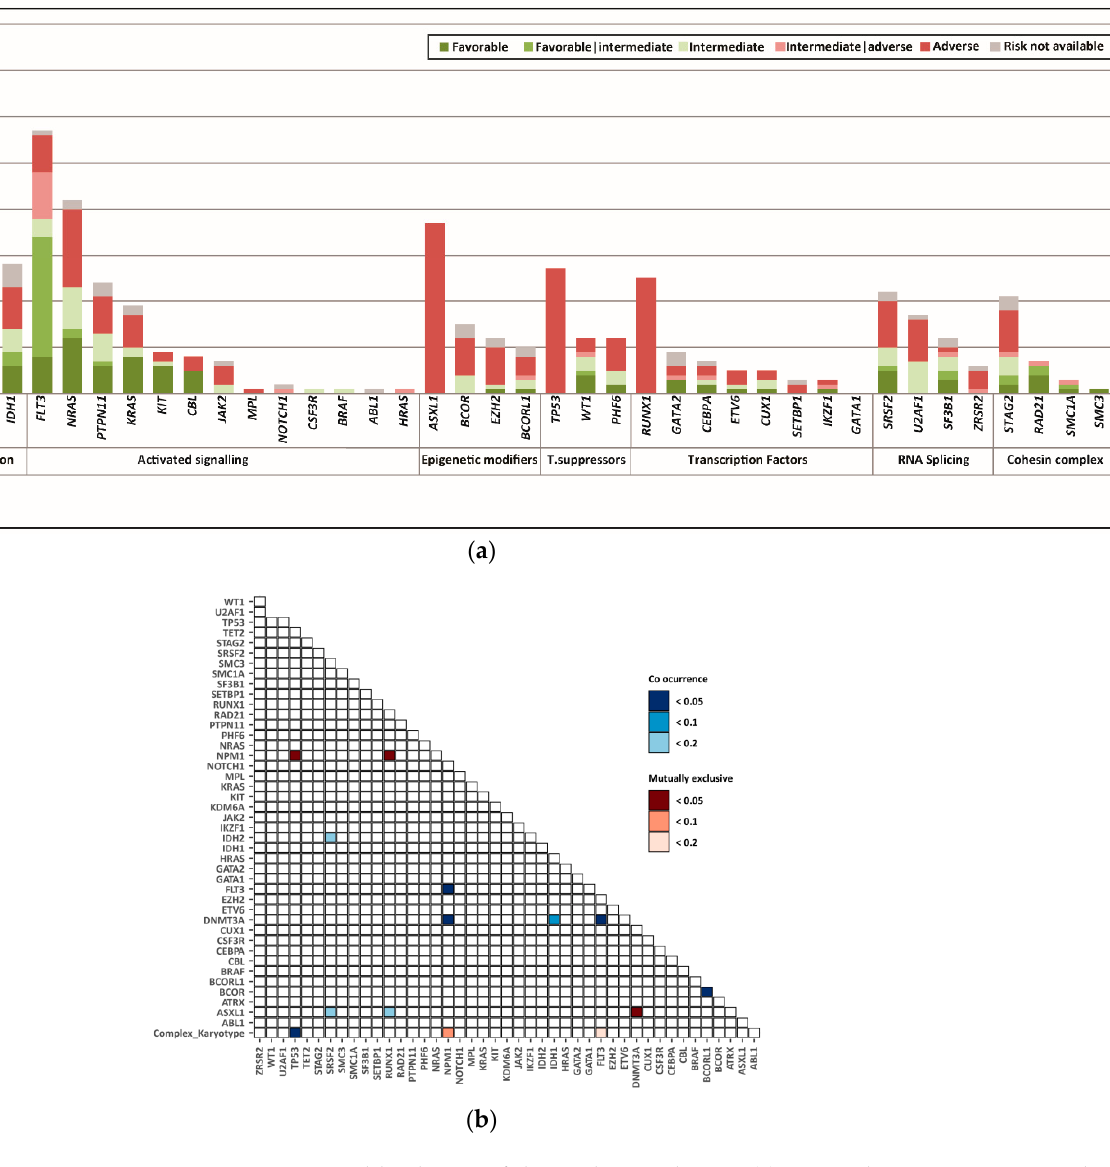
Figure 2. Mutational landscape of the study population. ( a ) Mutated genes were grouped into functional categories. Each bar represents patients harboring a mutation in the indicated gene. The colors in each bar indicate the risk group according to the ELN classification. Because the FLT3 -ITD allelic burden was not available, patients containing both FLT3 -ITD and NPM1 mutations were considered favorable|intermediate risk, whereas patients containing FLT3 -ITD but no NPM1 mutation were considered intermediate|adverse risk. ( b ) Pairwise associations among somatic mutations and complex karyotype alterations. Note that mutational profiling data was available for 269 patients, but karyoptype analysis was only available for 180 patients. Pairings with an adjusted q-value < 0.05 were considered to be significant. Pairings with more lenient q-value thresholds (0.1 and 0.2) are also presented. Blue colors indicate a positive association. Red colors indicate a negative association.